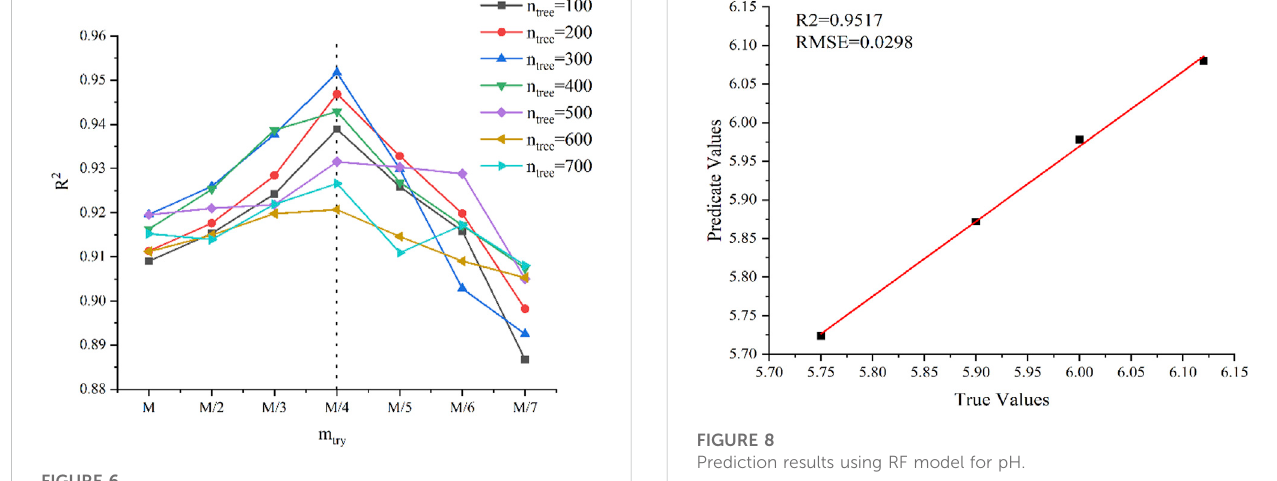
FIGURE 6 Prediction of R 2 with different values of n tree and m try .